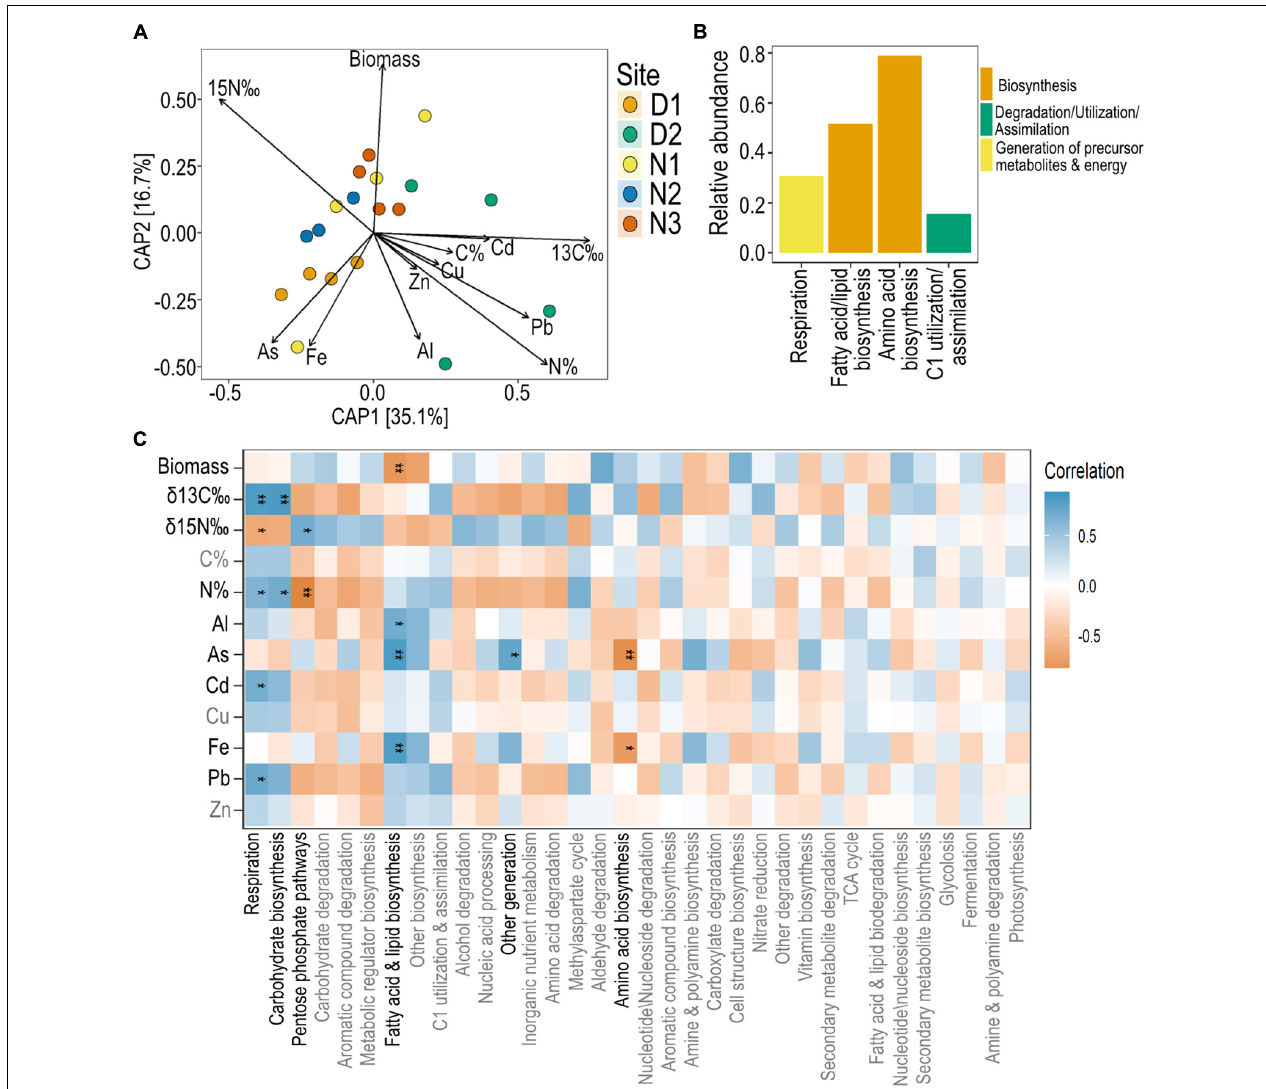
FIGURE 7 | Predicted bacterial functions of seagrass root microbiomes and their correlation with nutrient and metal concentrations. (A) Constrained Analysis of Principal Coordinates (CAP) model of PICRUSt2 predicted functions constrained by root properties (root biomass, root nutrients and root metal concentrations). (B) Top 10 most abundant predicted functions across all sites of seagrass roots at level 2. (C) Pearson’s correlation analysis between the top 40 most abundant PICRUSt2 predicted functions (agglomerated to level 2 functions) and seagrass root parameters with significant Bonferroni corrected p -values indicated with a *, where * = 0.05, ** <